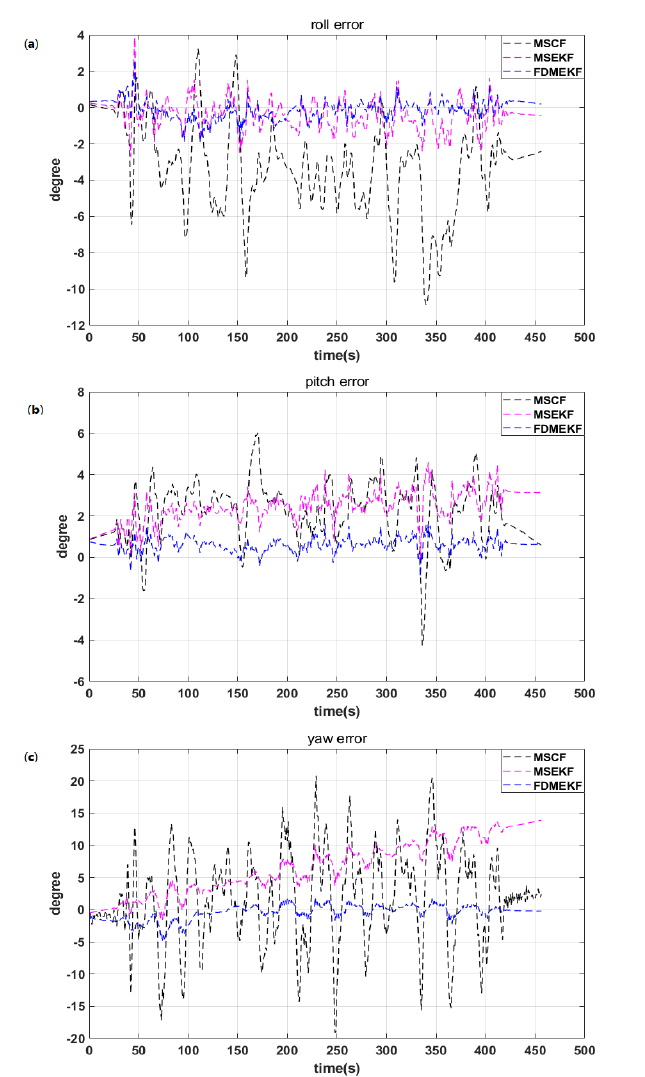
Figure 14. The attitude error of the UAV in flight. ( a ) the roll error of the UAV; ( b ) the pitch error of the UAV; ( c ) the yaw error of the